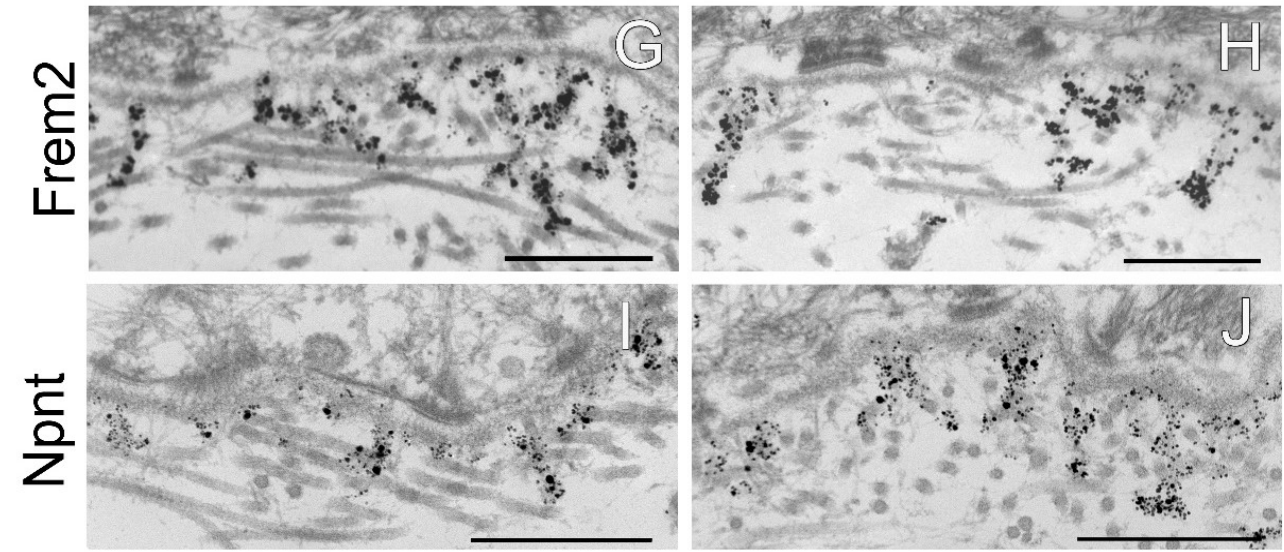
Figure 5. Immunogold electron microscopy analysis of the dermal–epidermal junction in AMACO- deficient newborn mouse skin. ( A ) An AMACO guinea pig antibody directs immunogold to anchor- ing cords, which insert into the subepithelial basement membrane and extend into the dermis. ( B ) Labeling for AMACO is absent in AMACO-deficient mice skin, however anchoring cords are clearly present (arrows). ( C , E , G , I ) Fras1, Frem1, Frem2, and nephronectin rabbit antibodies detect anchor- ing cords with a similar distribution as in AMACO-deficient skin ( D , F , H , J ). Scale bars = 500 nm.